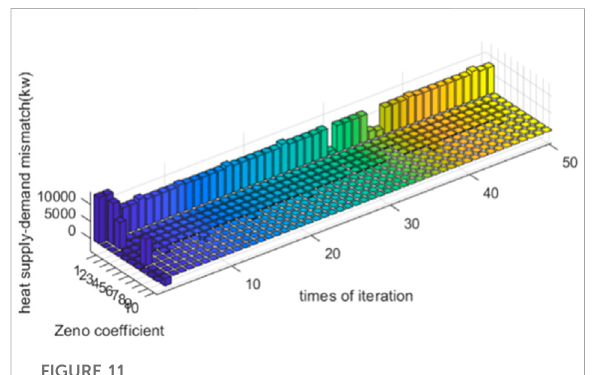
FIGURE 11 Heat mismatch with larger factor.